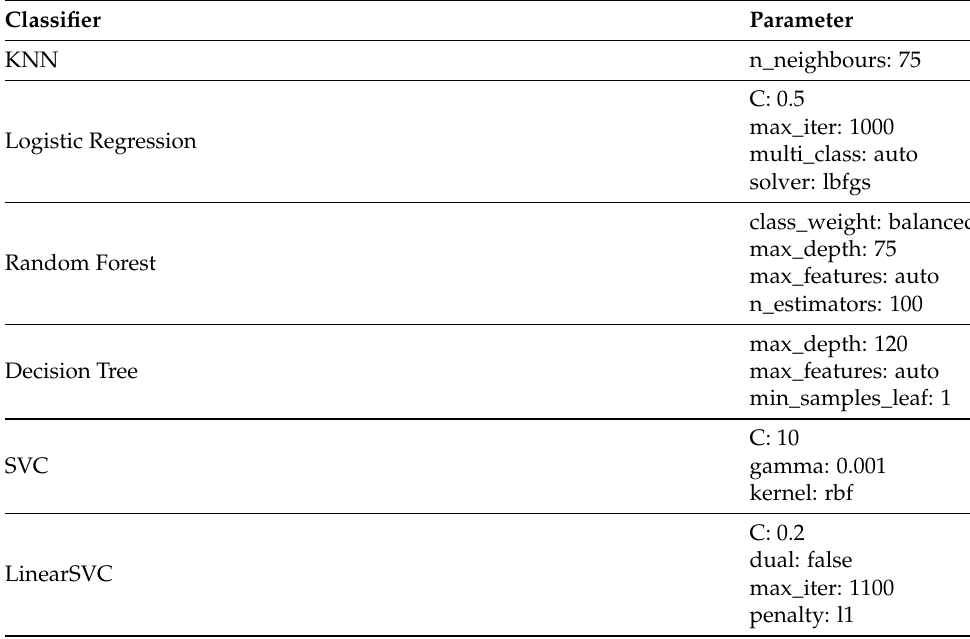
Table 2. Cuisine classification classifier parameters after grid